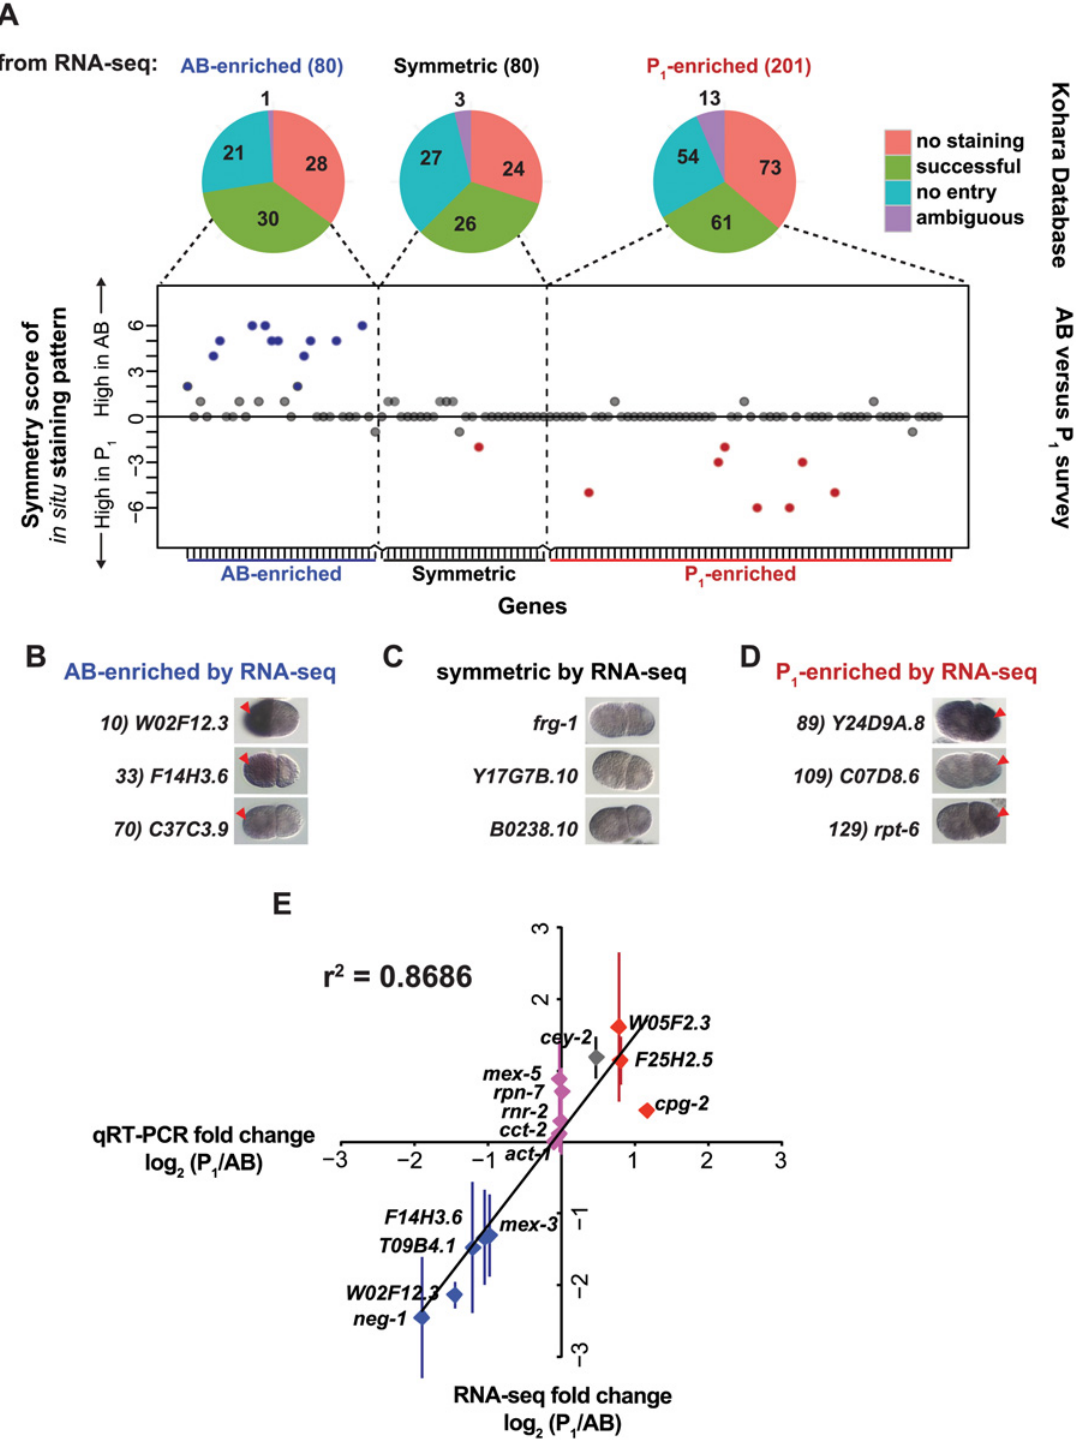
Fig 2. Complementary methods, in situ hybridization and qRT-PCR, support RNA-seq measurements. (A) The 80 AB-enriched, the 201 P 1 -enriched, and a subset of the middle 80 symmetric transcripts (S3 Dataset) were queried in a publically available collection of in situ hybridization images [34]. Pie charts show the proportion of transcripts with no entry (blue), successful staining (green), those that were in the database but showed no signal in any of the samples (No staining, red), and those that were otherwise interpretable due to overexposure, focus, or other problems (ambiguous, purple). Successfully stained entries were scored in a blind survey, and their results are plotted for each entry queried. Transcripts with scores higher than 2 are marked in blue